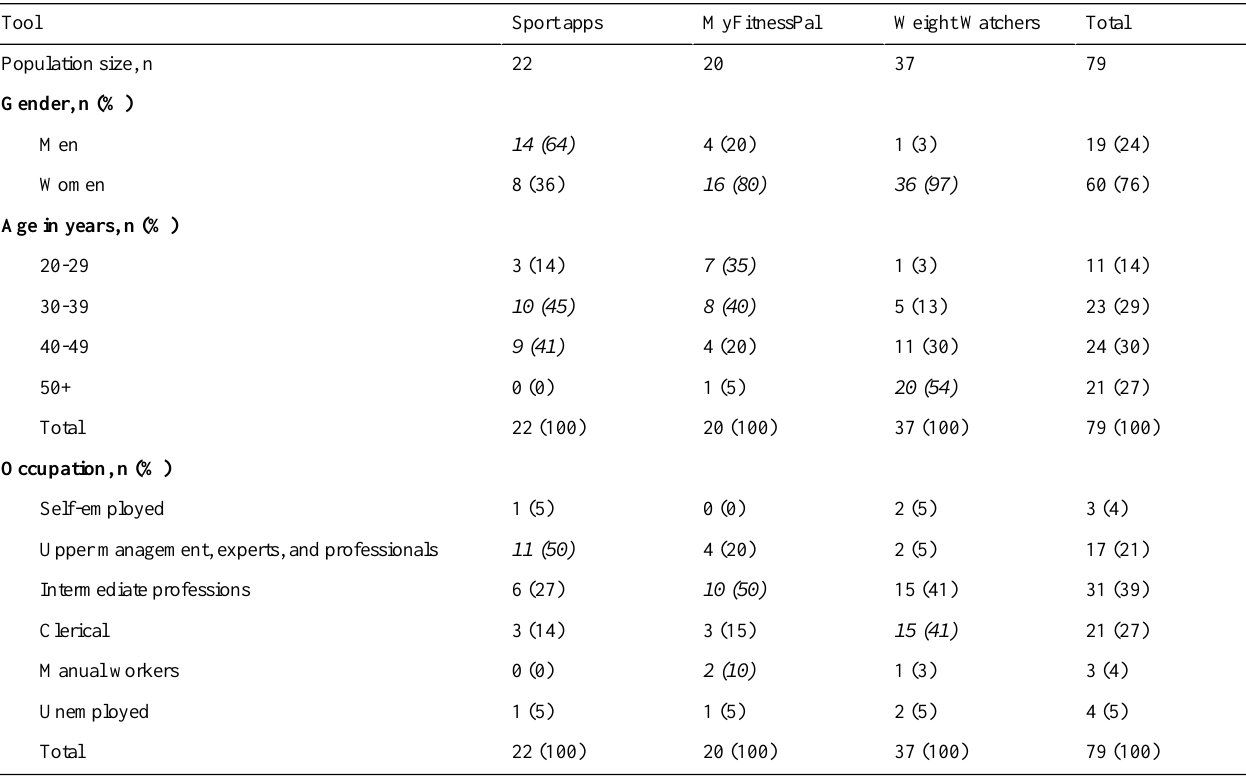
Table 2. Sociodemographic characteristics of the participants. Values with statistically significant overrepresentation ( P <.05) are italicized.